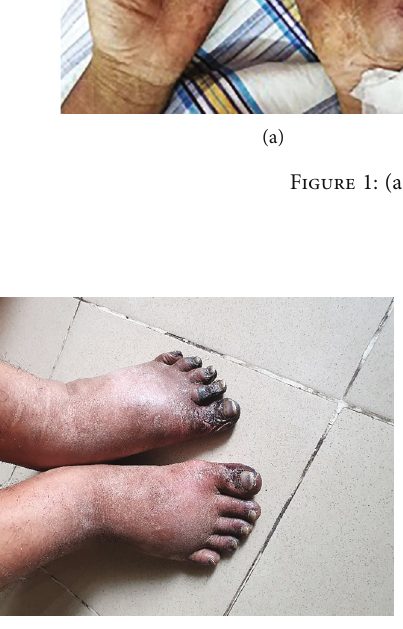
Figure 2: Digital necrosis a ff ecting the